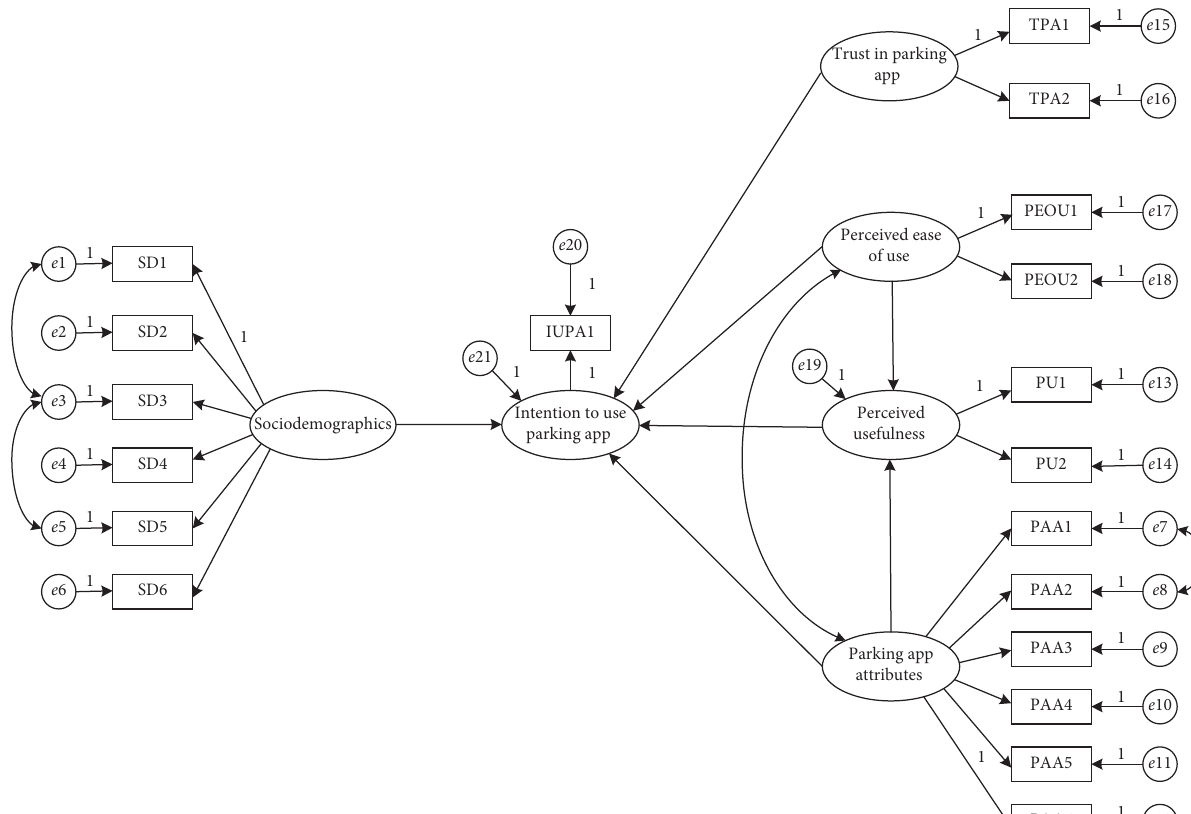
Figure 3: SEM of drivers’ intention to accept parking